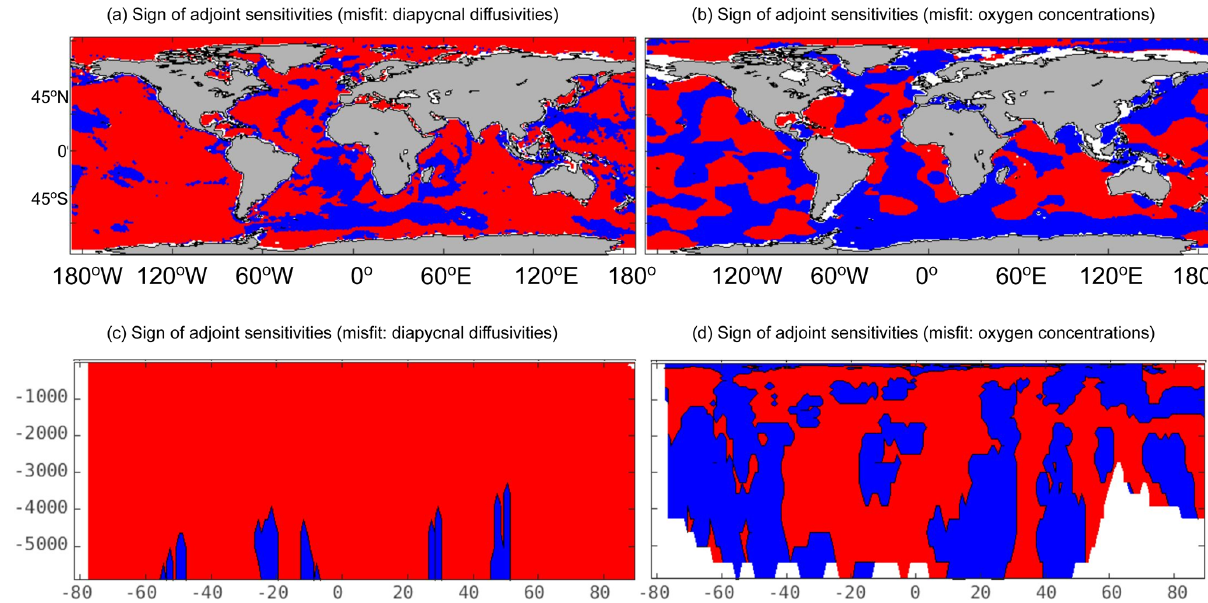
Figure 10. Adjoint sensitivity sign comparisons: same as Fig. 8, but with the de Lavergne et al. (2020) product, κ ρ, tides .